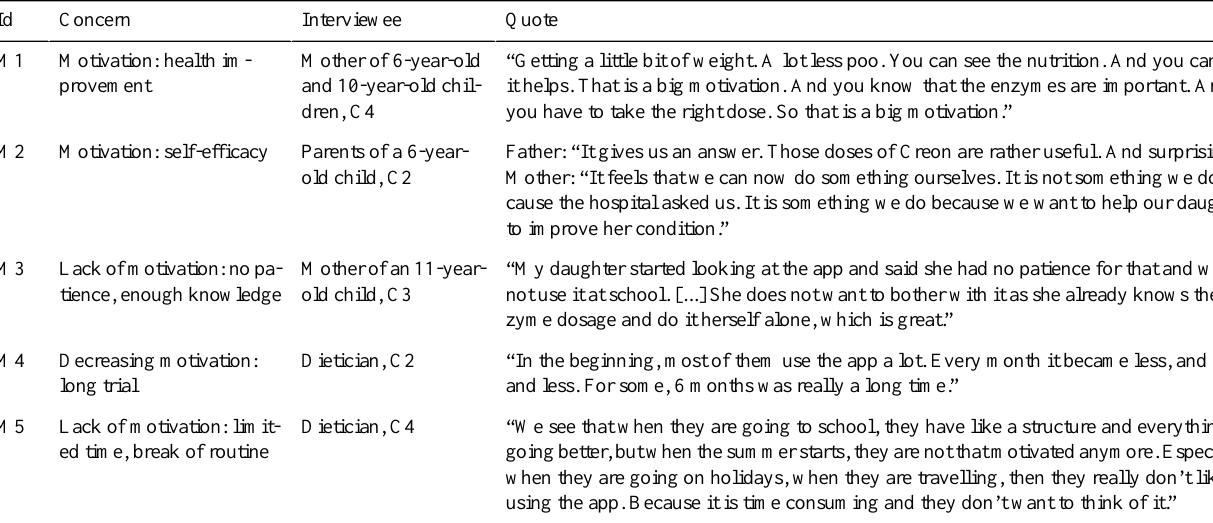
Table 3. Illustrative quotes related to using the self-management app: varying motivation to use the app. QuoteIntervieweeConcernId